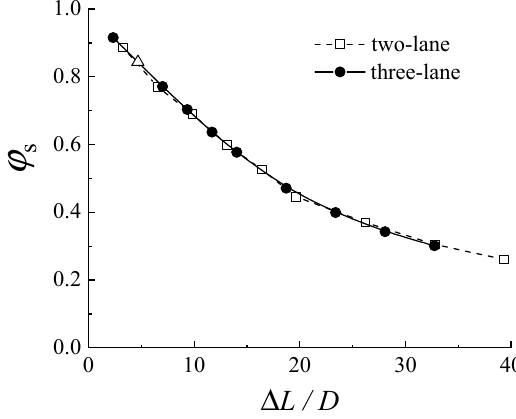
Figure 7. Impacts of ∆ L / D on series-flow ratio ϕ s .